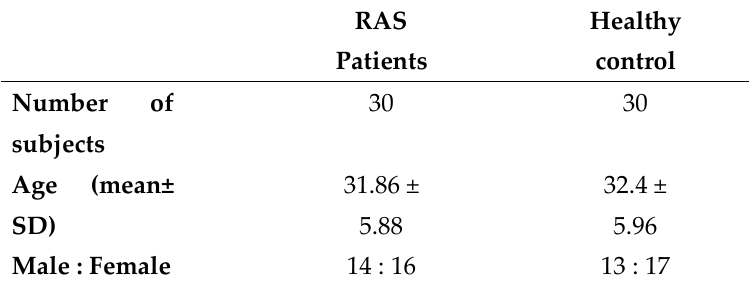
Table 1: Demographic information of the RAS patients and controls